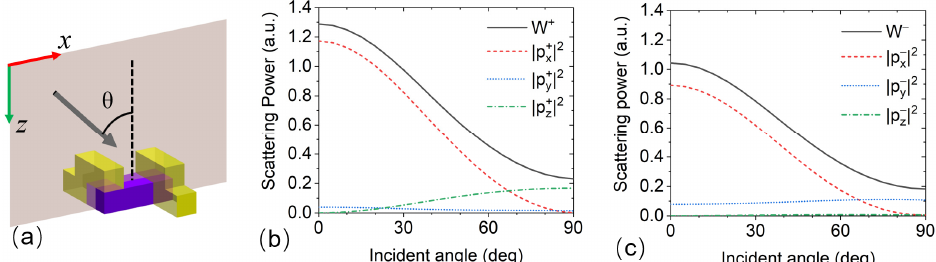
Figure 2. ( a ) The schematic of a single plasmonic molecule illuminated using LCP and RCP light. The wavevector is in the xz plane, and the angle between incident direction and z-axis is θ . ( b , c ) the total scattering power (solid curves) and the intensities of the three components of electric dipole (dash curves), when the incident light is LCP and RCP, respectively.